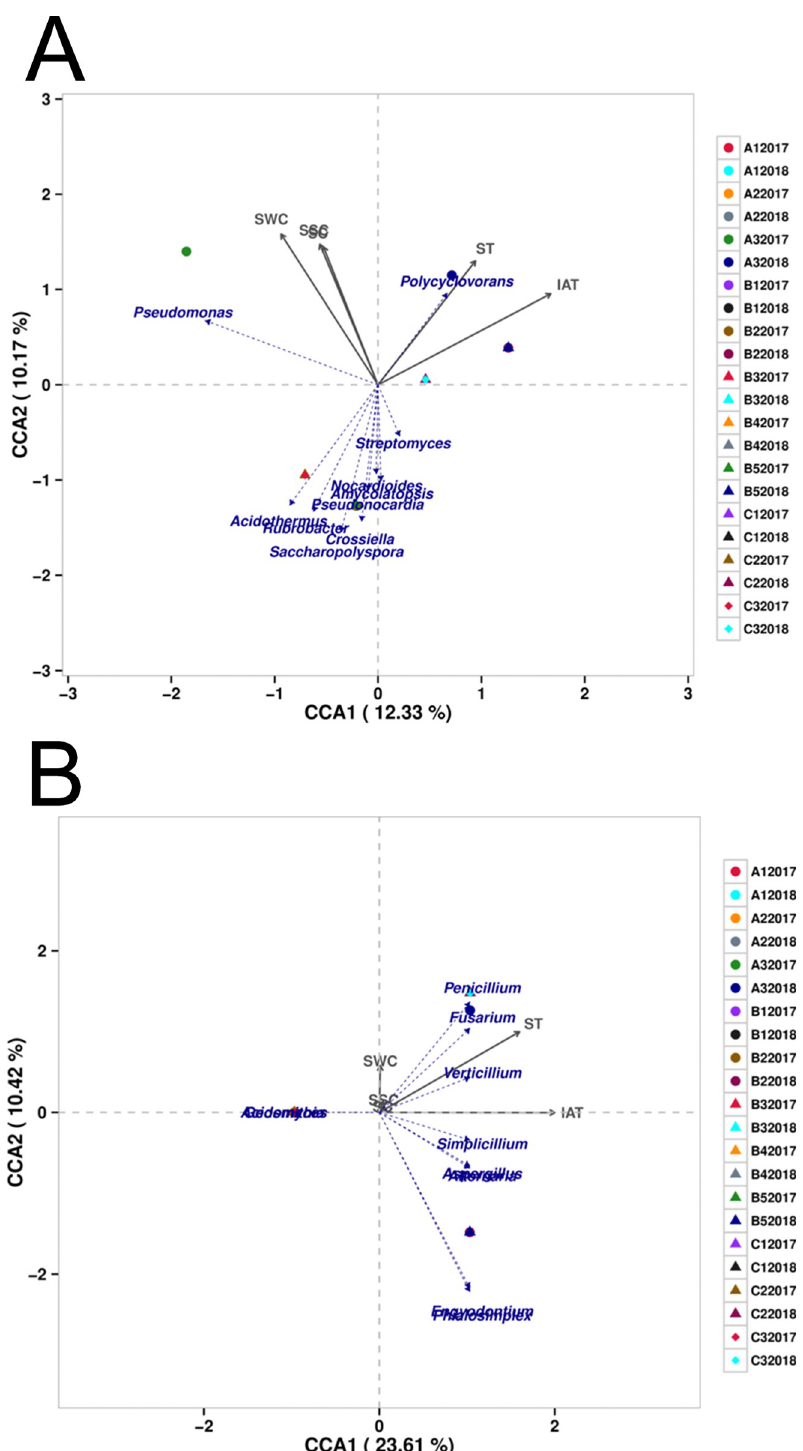
Fig 7. CCA ordination biplot between environment factors and bacterial communities(A) and fungal communities (B) in 2017 and in 2018.